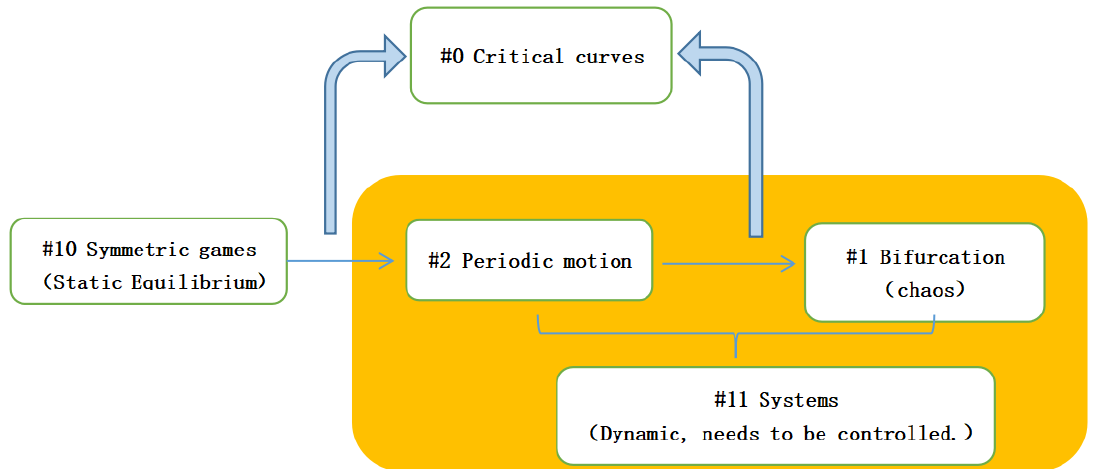
Figure 10. Evolutionary paths of bifurcation and chaos.